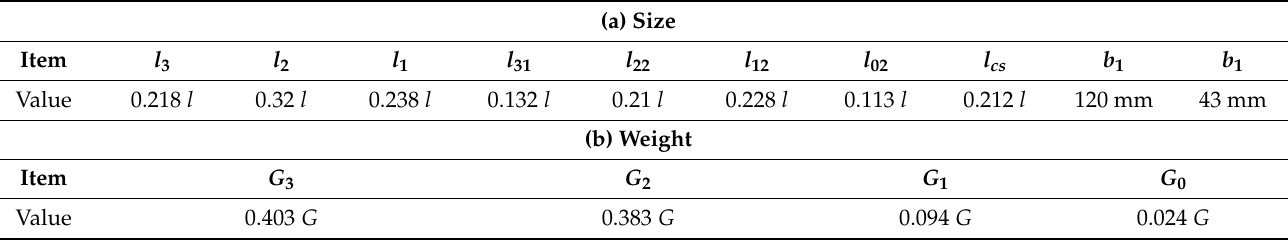
Table 1. The parameters of the